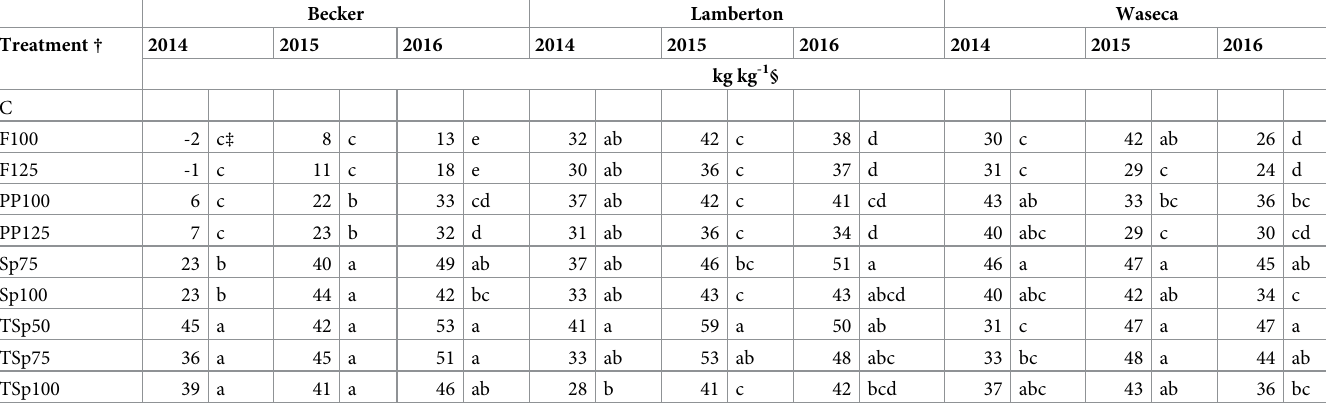
Table 5. Agronomic efficiency of applied N fertilizer as affected by treatment, location, and year.